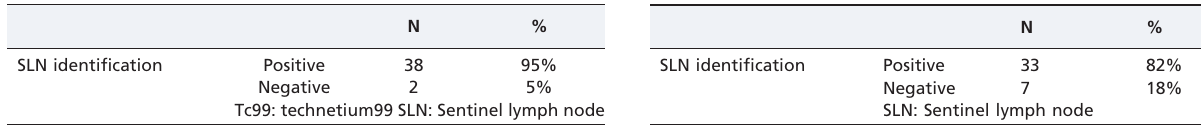
Table 2 - Identification of the SLN in the bitch axilla using the sub-areolar injection of Tc99 into that region of the right and left breasts.